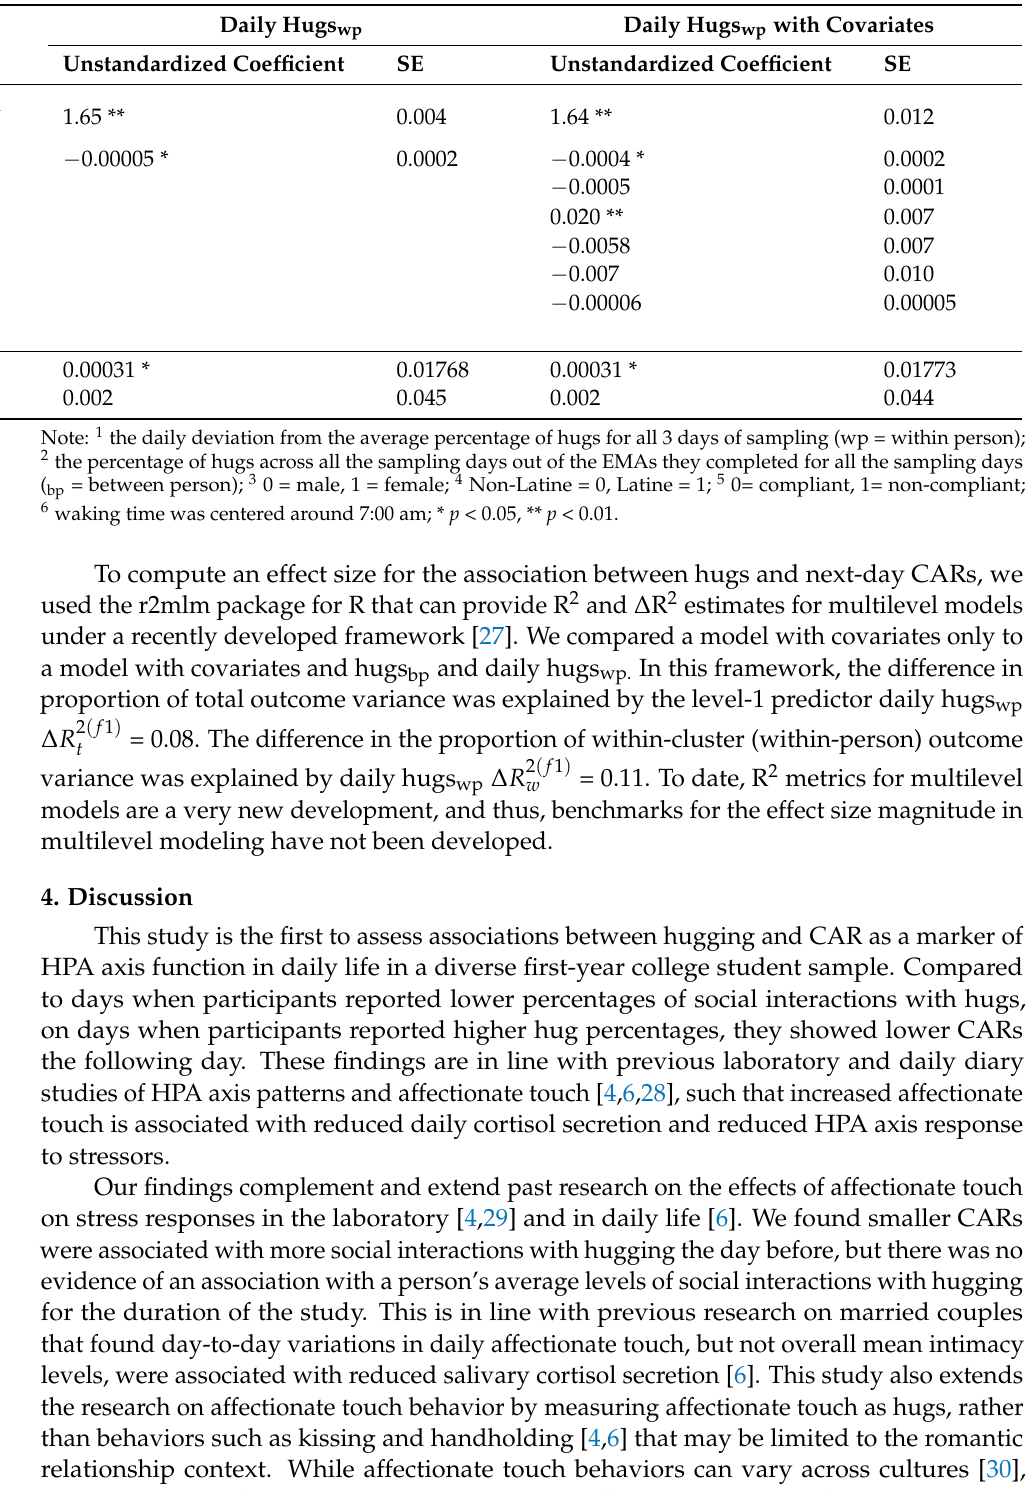
Table 3. Hierarchical linear models predicting CAR by hugging percentage using full information maximum likelihood